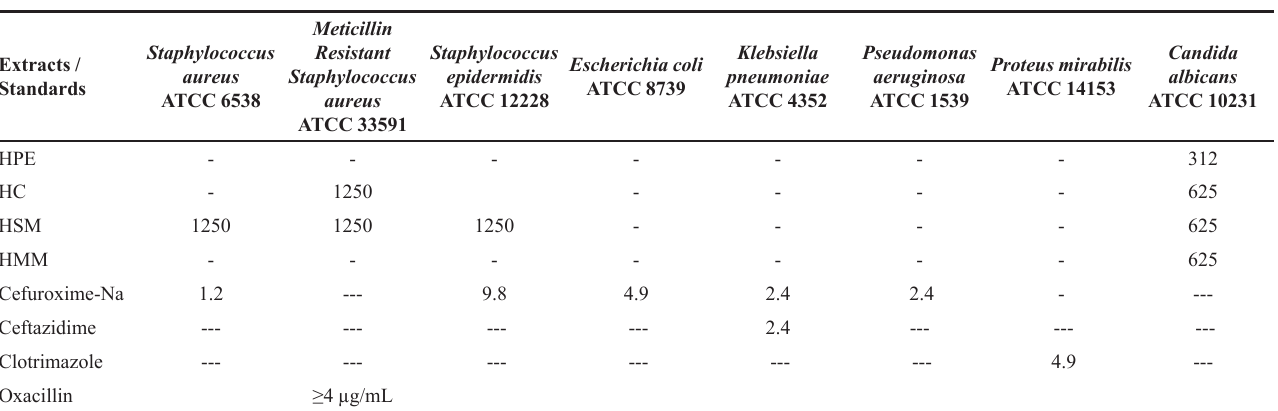
TABLE IV - The antimicrobial activity of H. plicatum subsp. plicatum extracts